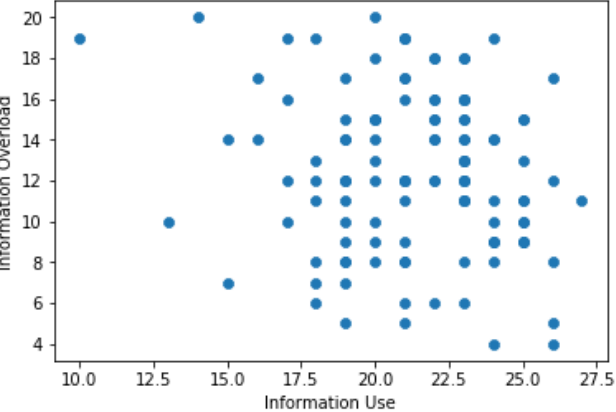
Figure 3. Lack of Correlation Between Outcome